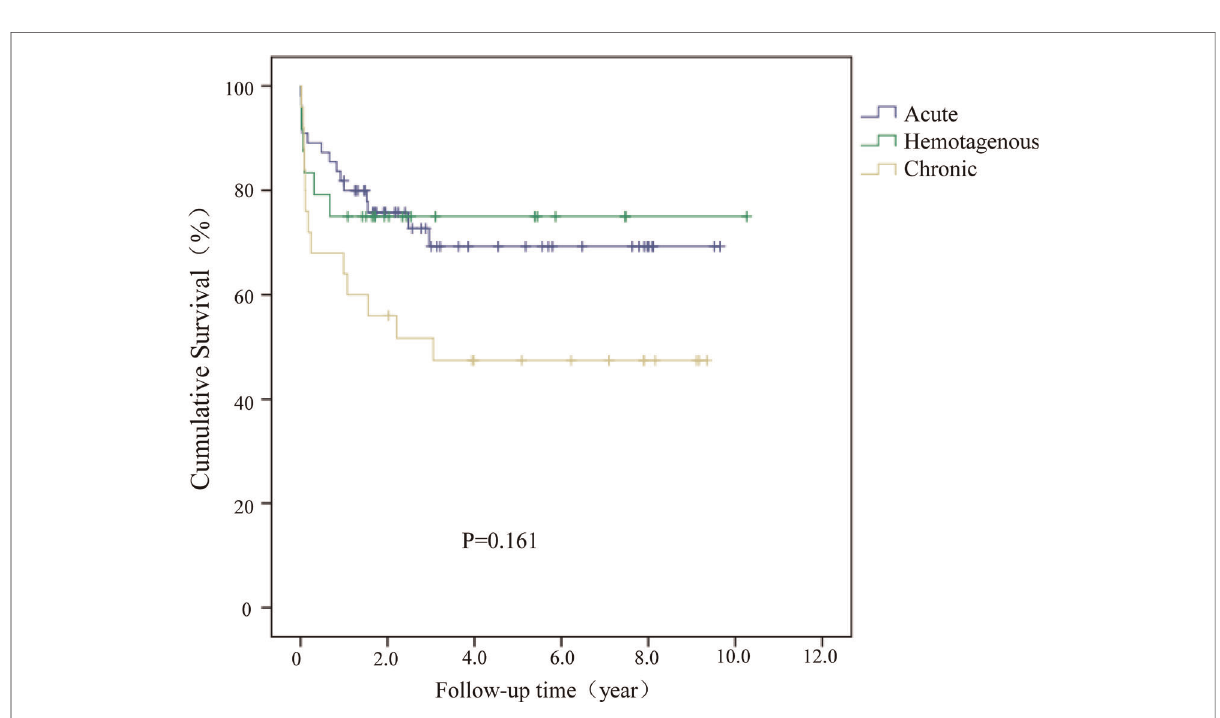
FIGURE 3 Kaplan – Meier (KM) survival analysis for acute, hematogenous, and chronic cases of